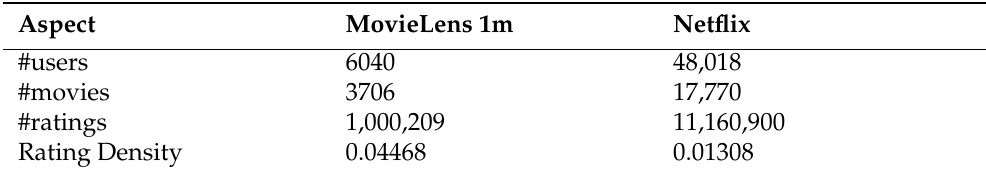
Table 3. Descriptions of the MovieLens 1m and Netflix datasets